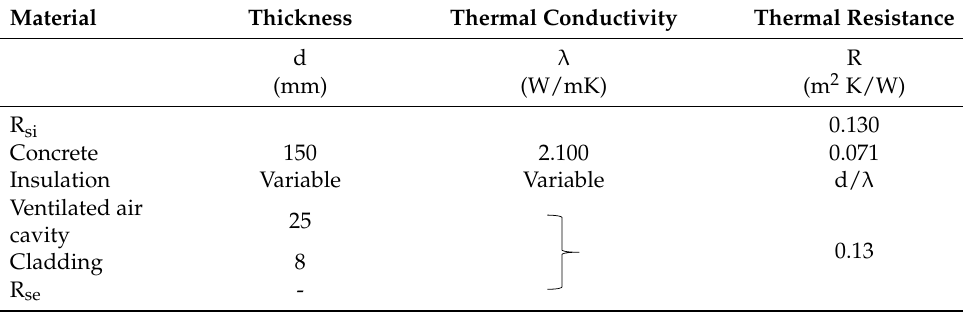
Table 4. Definition of the specific wall applied to Scen wall